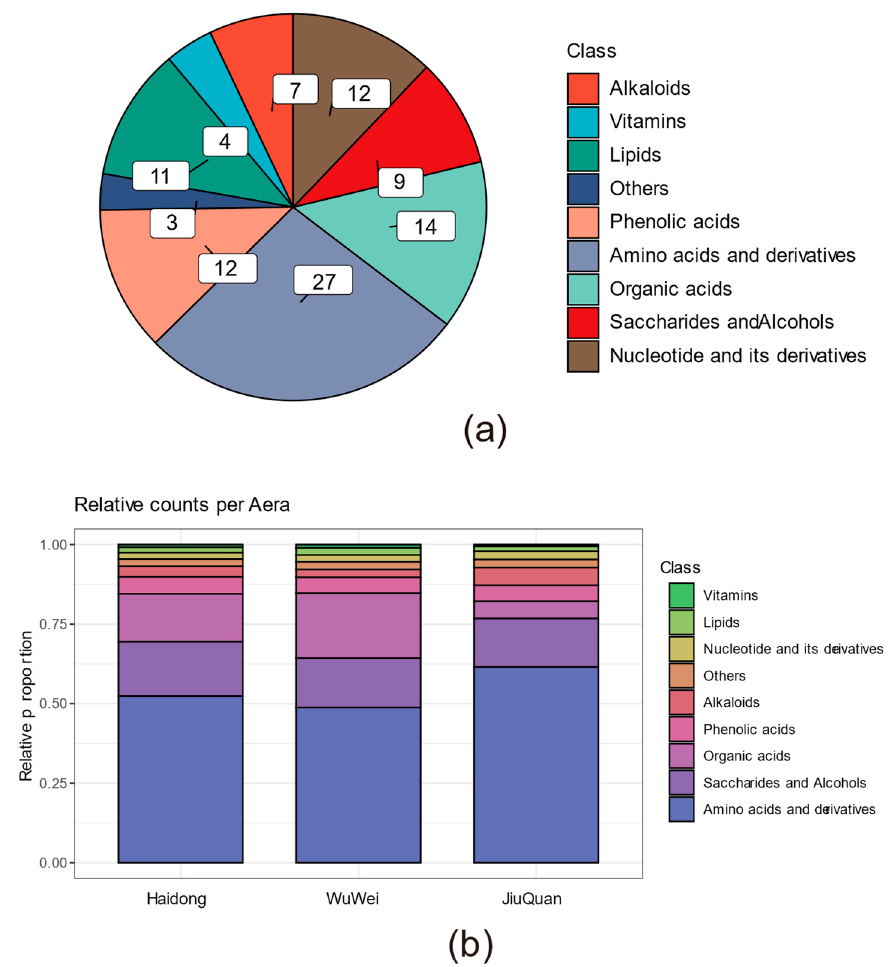
Figure 3. Classification of differential metabolites. ( a ) Pie chart showing differential metabolite classification. ( b ) The difference in the relative content of each metabolite class. The relative content of each metabolite class is summed by the content of the individual metabolites in them.